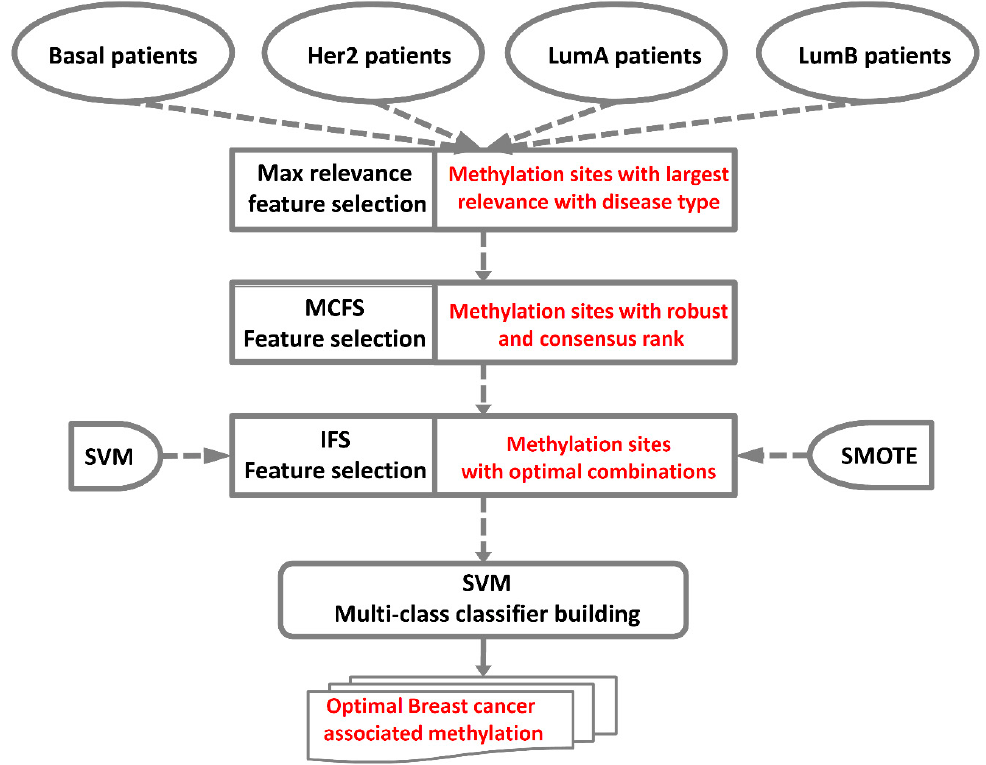
Figure 6. Flowchart for classifying samples from four breast cancer subtypes.